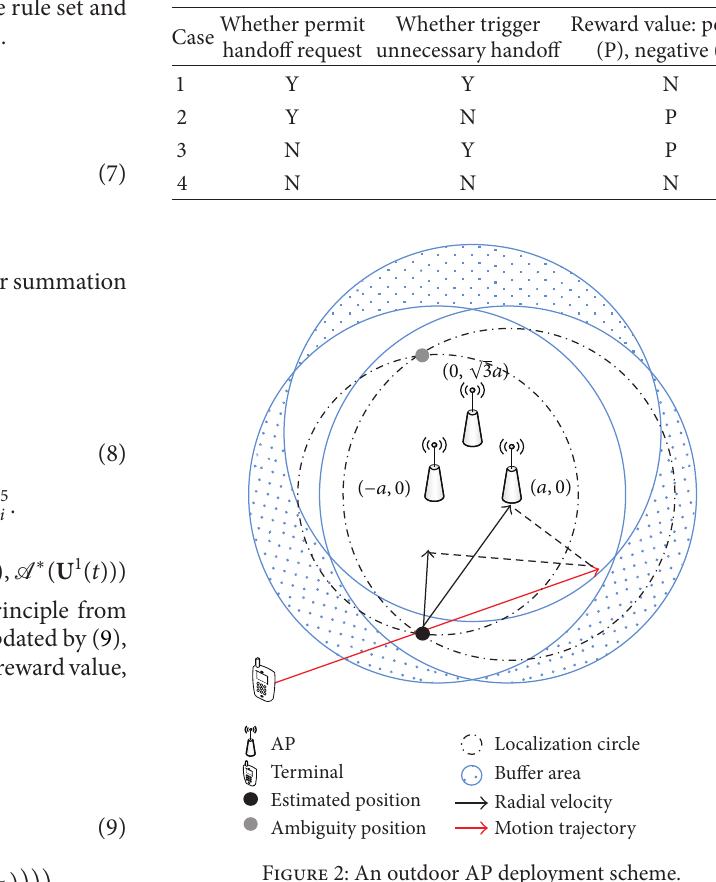
Table 1: Reward scheme of Q-NFIS.